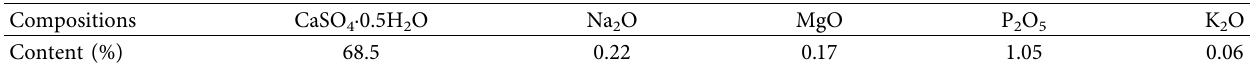
Table 1: Mineral components of PG.